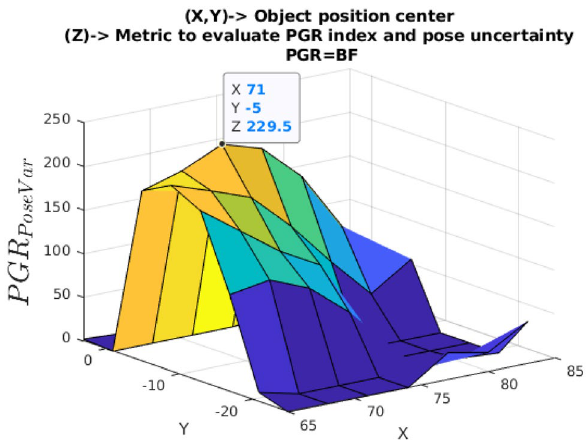
Fig. 15 PGR index for each (X,Y) position of the cube